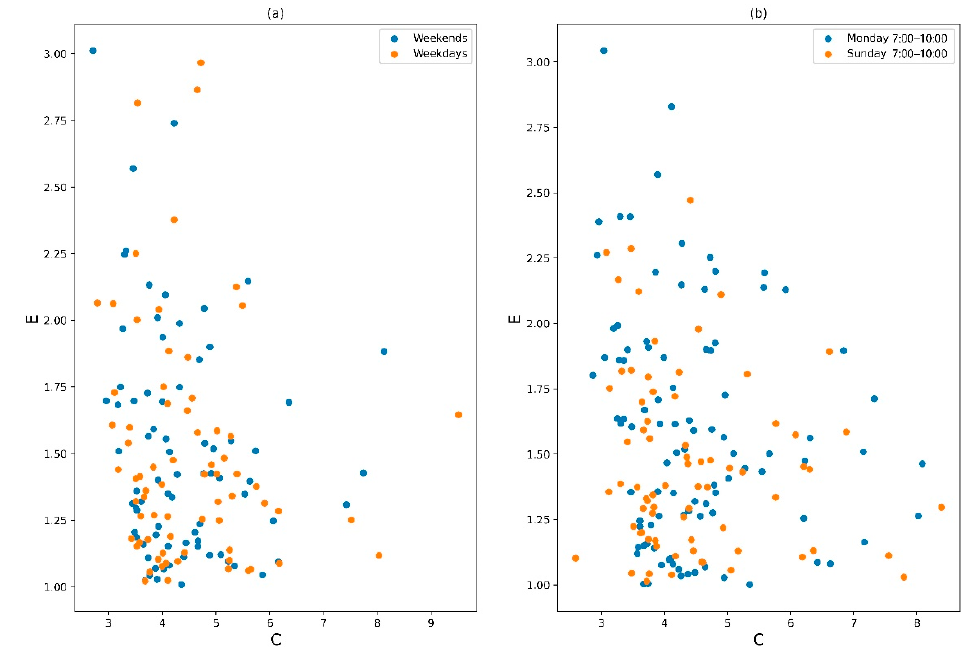
Figure 10. The compactness of MUCs. ( a ) A comparison between weekdays and weekends; ( b ) a comparison between Monday and Sunday.